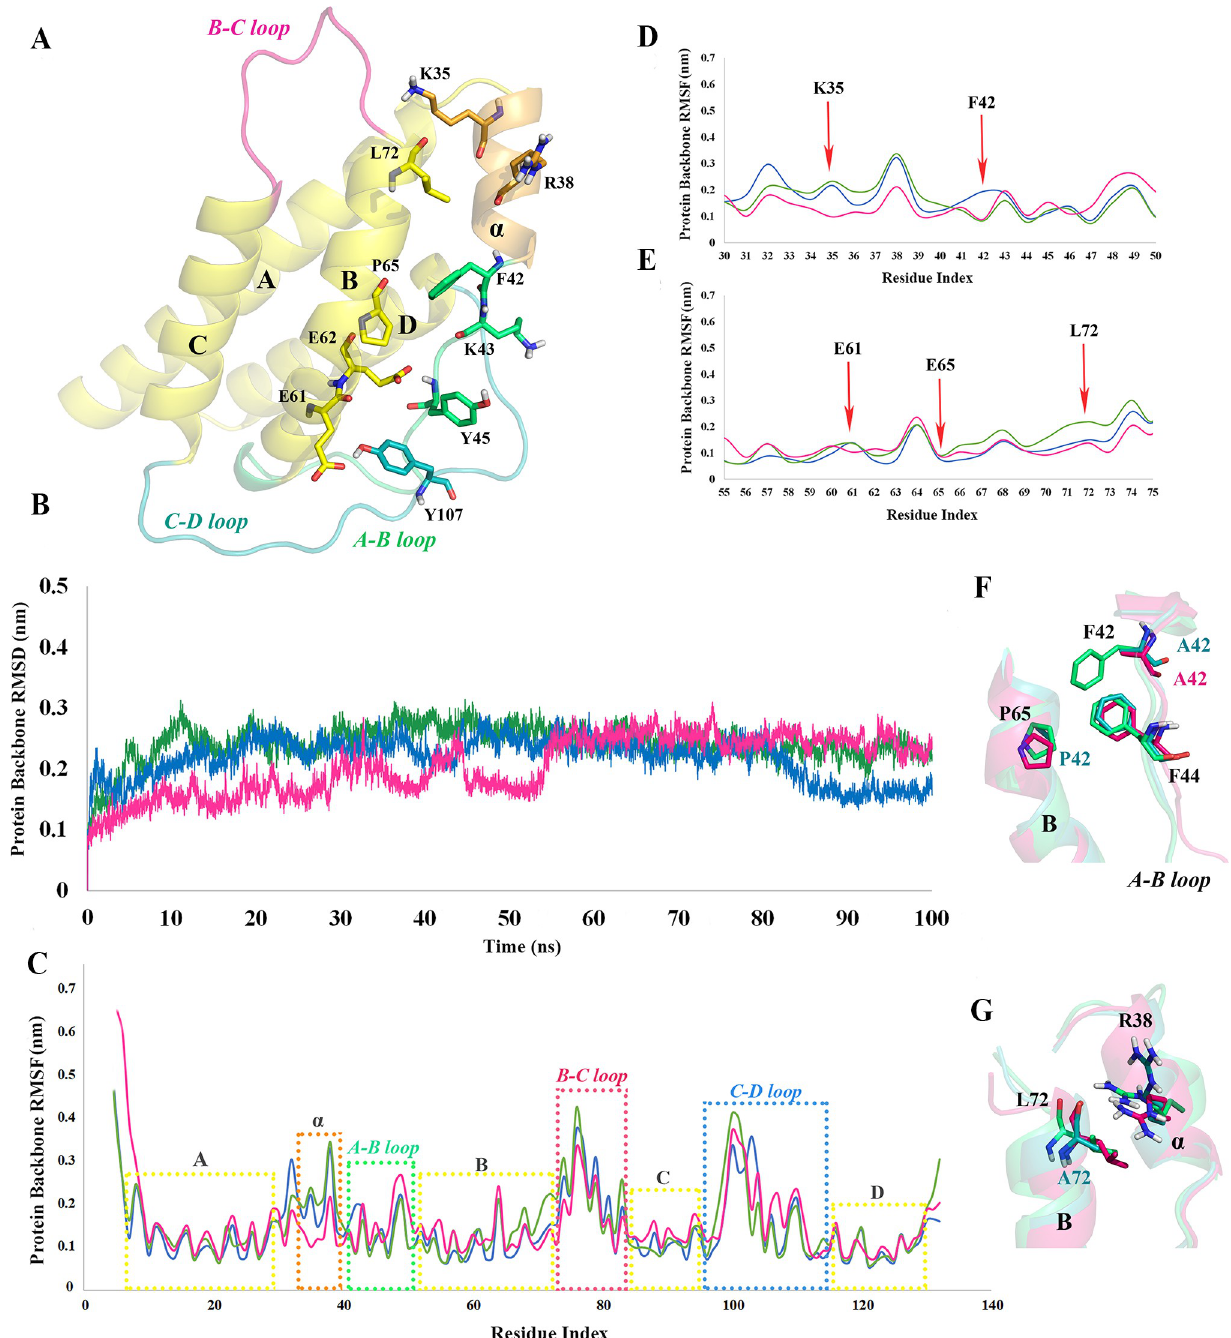
Fig 1. A. IL-2 protein structure (hot spot residues in sticks), B. Back-bone root mean square fluctuations (RMSD) of the native (green), mutant 1 (blue) and mutant 2 (magenta) protein, C. Per-residue root mean square fluctuations (RMSF) of the native (green), mutant 1 (blue) and mutant 2 (magenta) protein residues, D. Per-residue root mean square fluctuations (RMSF) of the target residues 30–50 close view, E. Per-residue root mean square fluctuations (RMSF) of the target residues 55–75 close view, F. Residues F42, F43 and P65, and g. Residues L72 and R38. residues participating different structural arrangements (Fig 2A–2C). According to Fig 2D–2F, the assigned mutations has decreased the number of α -helix participating residues from 55%